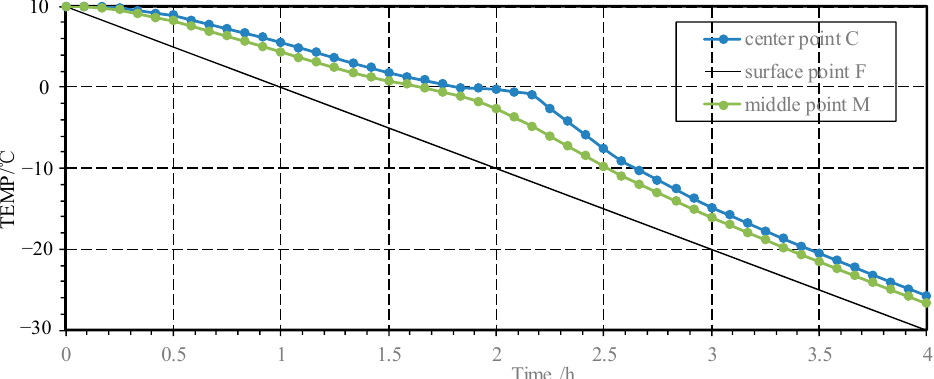
Figure 4. Temperature distribution of Mortar specimen.